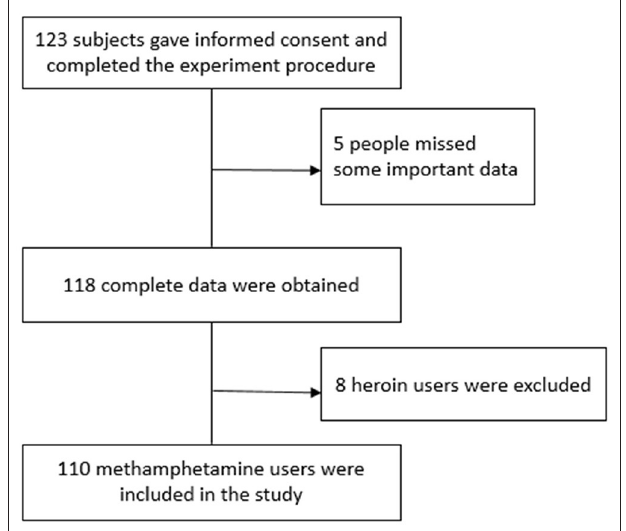
FIGURE 1 | CONSORT flow